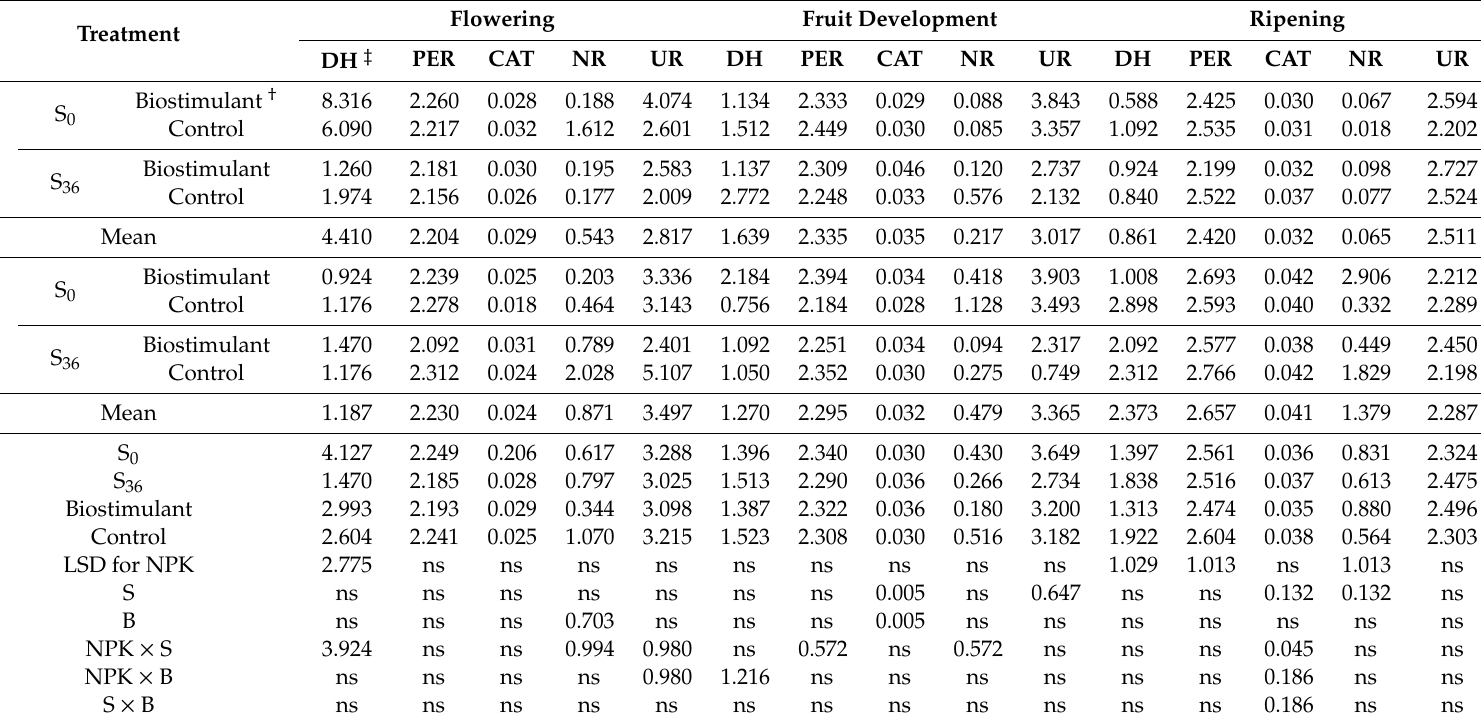
Table 2. Enzyme activity in soil depending on the mineral fertilization level and biostimulant application, mean from 2011–2013. Flowering Fruit Development Treatment